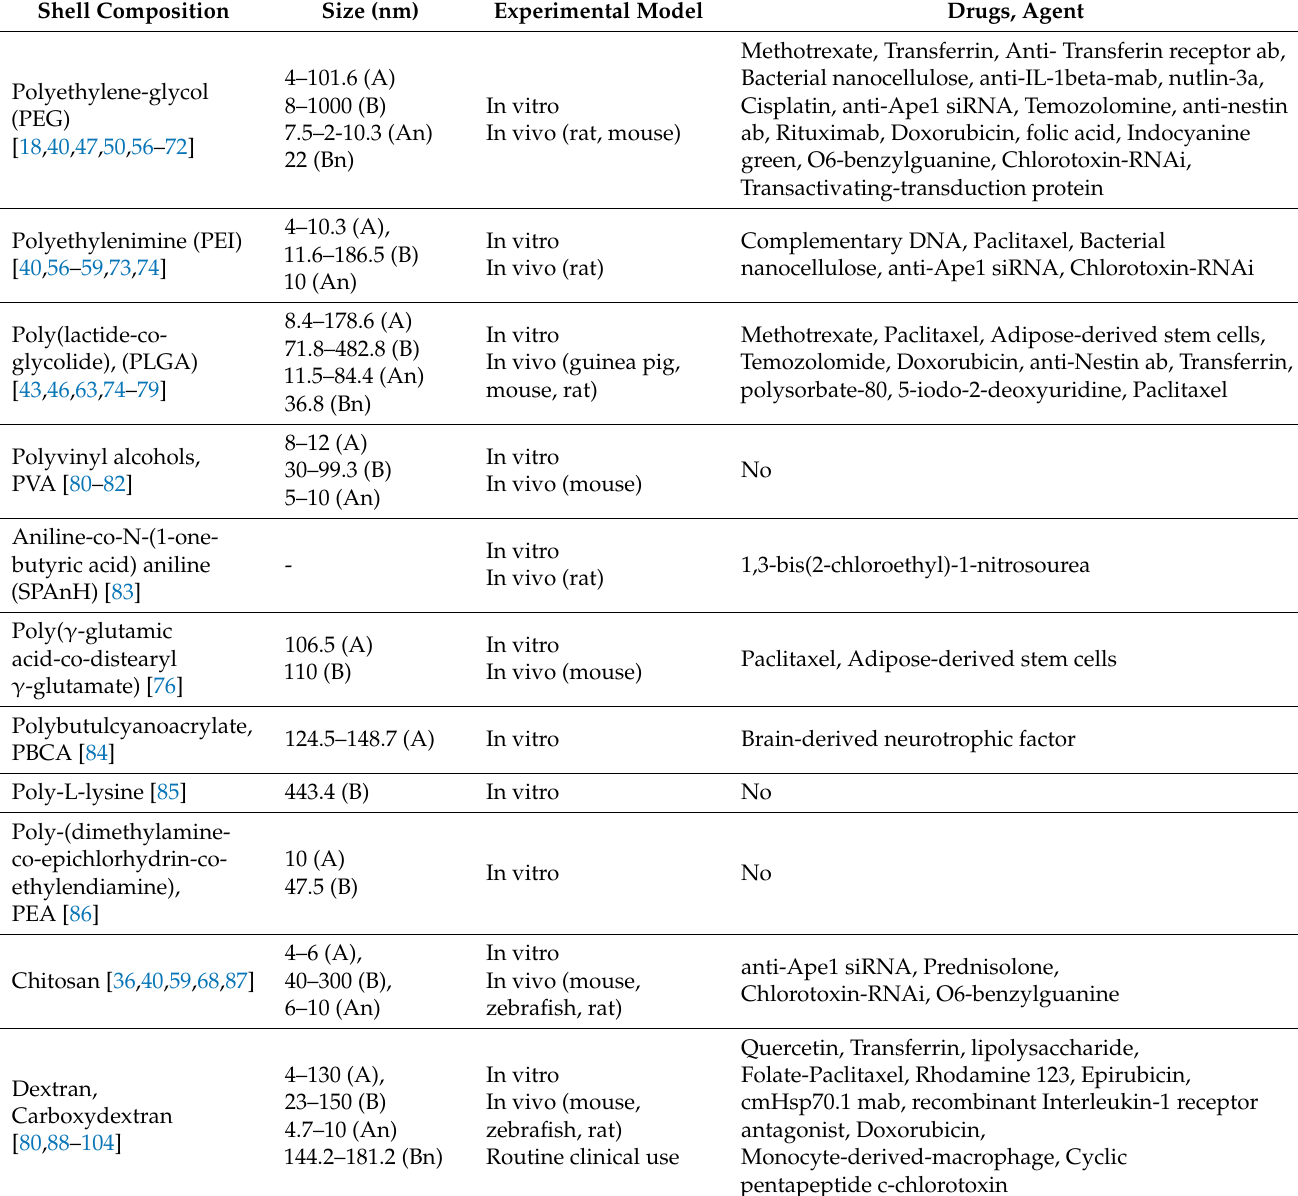
Table 1. Different kind of polymer shell using to coat SPIONs. A: core size with shell (Transmission Electron Microscopy), B: hydrodynamic size with shell (Dynamic Light Scattering), An: naked core size, Bn: naked hydrodynamic